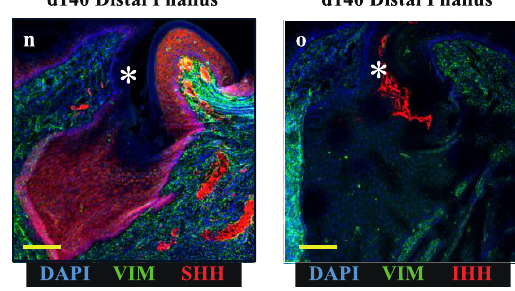
Figure 2. Sonic hedgehog (SHH) and Indian hedgehog (IHH) localize to discrete regions of the developing phallic epithelium. Day 20 male phallus immunolabelled for SHH (red—a, c, e, g, h, j) or IHH (red—b, d, f, i, k) and vimentin (green—all images). Dotted box denotes magnified portion in adjacent image. The expression of SHH in the distal phallic epithelium at day 20 ( a ), day 60 ( c ) and